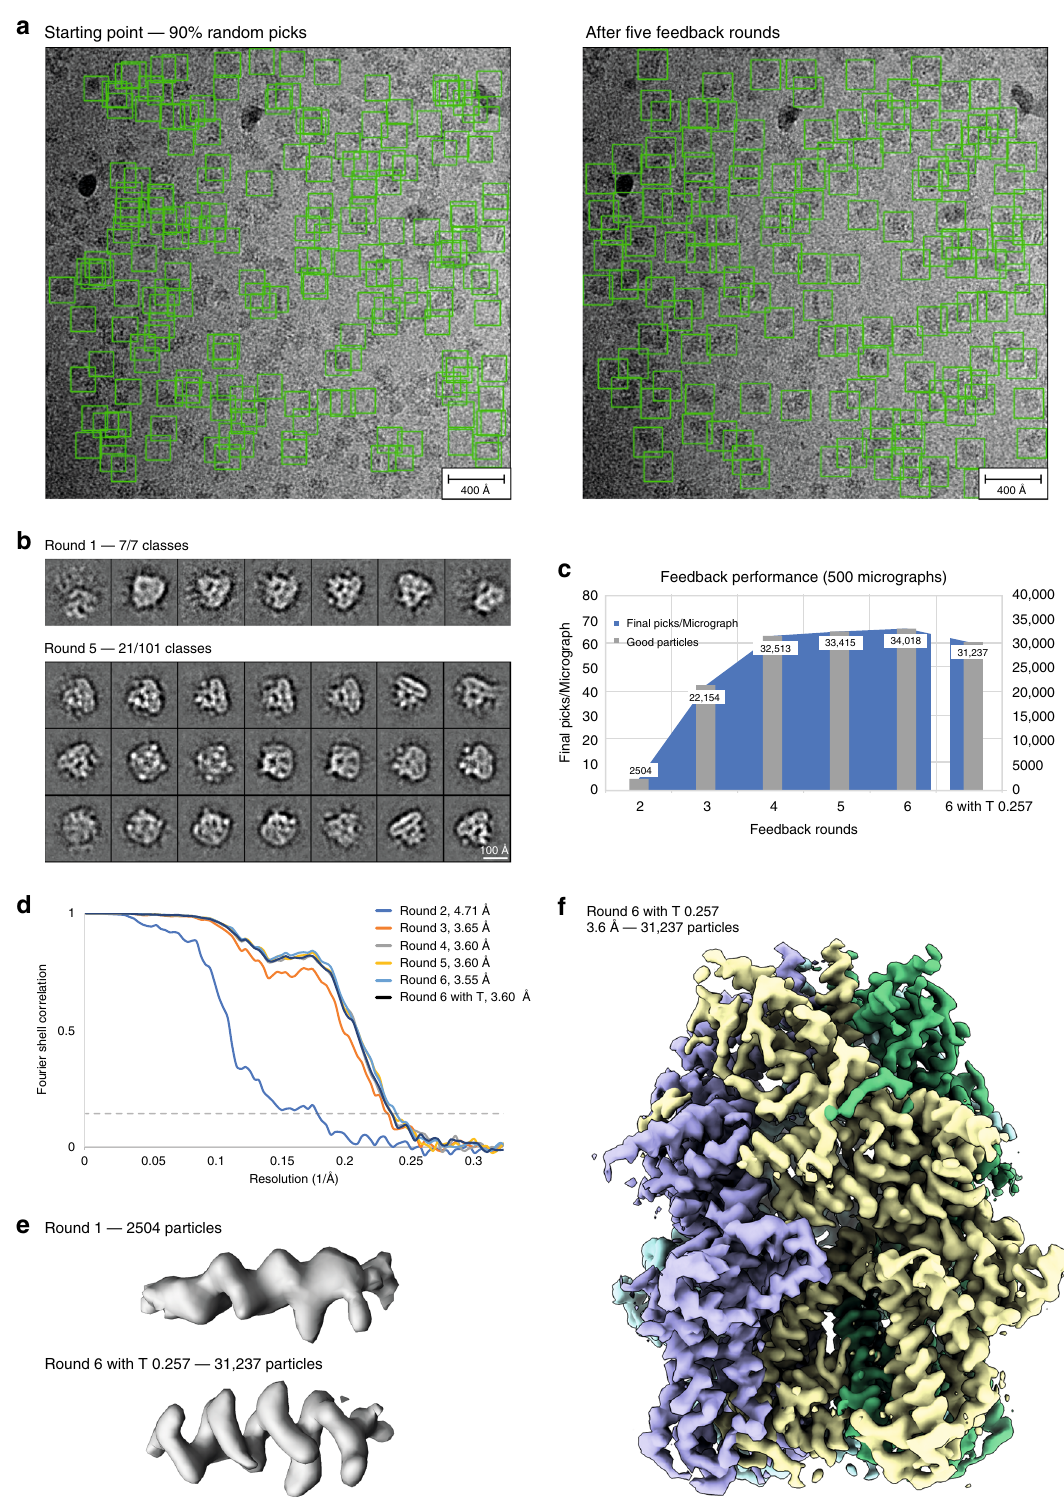
Fig. 3 Processing the TRPC4 membrane channel using a deliberately hampered picking model. a To simulate low quality picking, only 10% of the initial crYOLO picks were used while the remaining 90% were re-positioned randomly (left). After the feedback loop crYOLO reliably picks the TRPC4 particles (right). b Total amount of 2D class averages produced in the fi rst iteration of the feedback loop (top) and 21 representative averages produced in the fi nal iteration of the feedback loop (bottom). c Progression of the number of particles labeled “ good ” when applying the intermediate picking models of the feedback loop to a fi xed subset of 500 micrographs. The curve fl attens out in the fi nal iterations, indicating the convergence of the feedback loop optimization. d Fourier shell correlation (FSC) curves of the individual 3D reconstructions computed from particles labeled “ good ” (also see c ). e Representative α -helix (amino acids 600 – 615) illustrating the improvement of the density when using the fi nal (bottom) compared to the initial (top) picking model. f 3D reconstruction of TRPC4 computed from 500 micrographs using the optimized picking